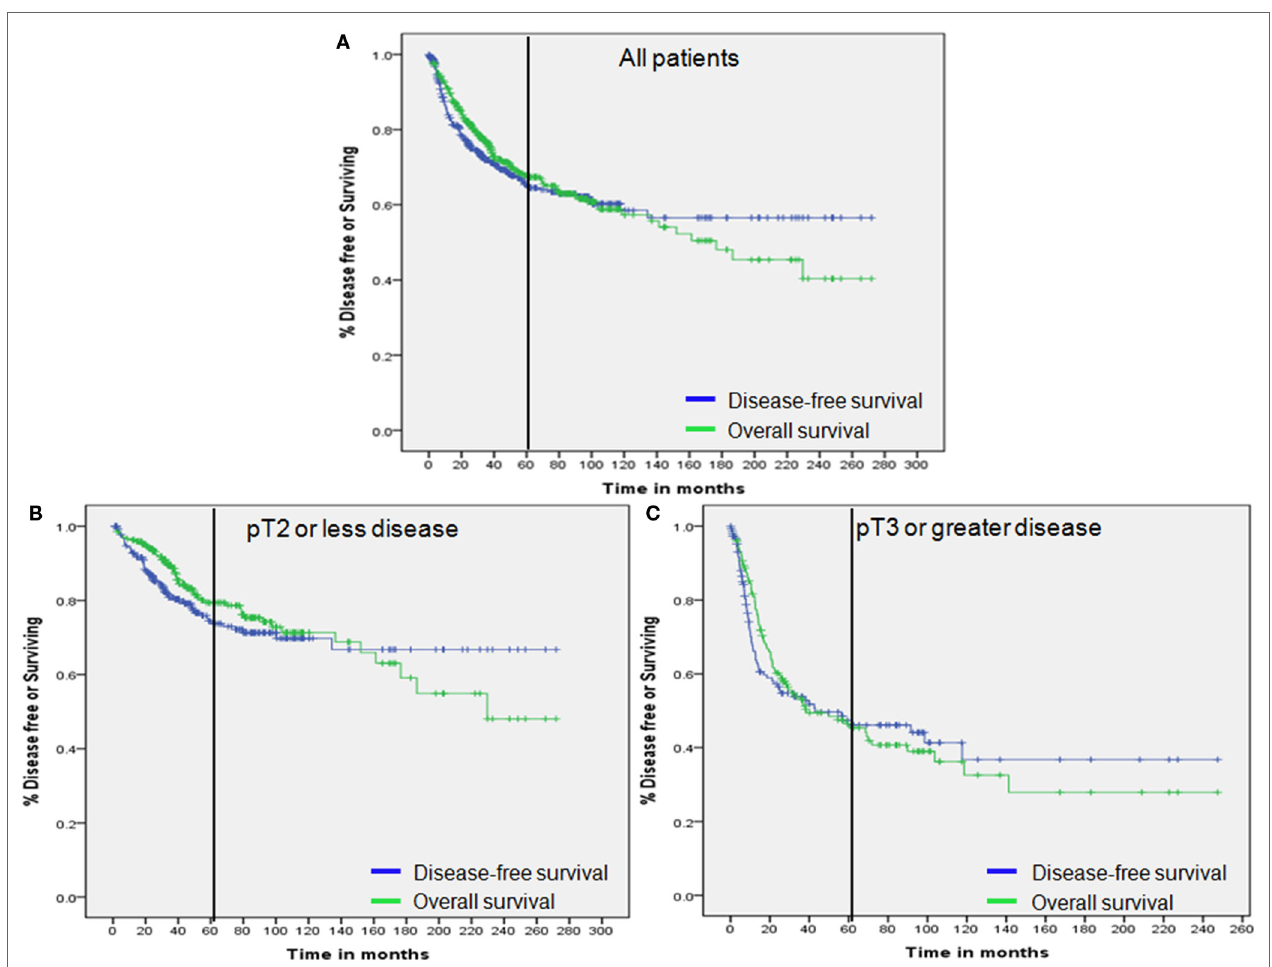
FigUre 1 | Overall survival and disease-free survival . (a) All patients. (B) Patients with pT2 or less disease. (c) Patients with pT3 or greater disease. Vertical bar represents 60